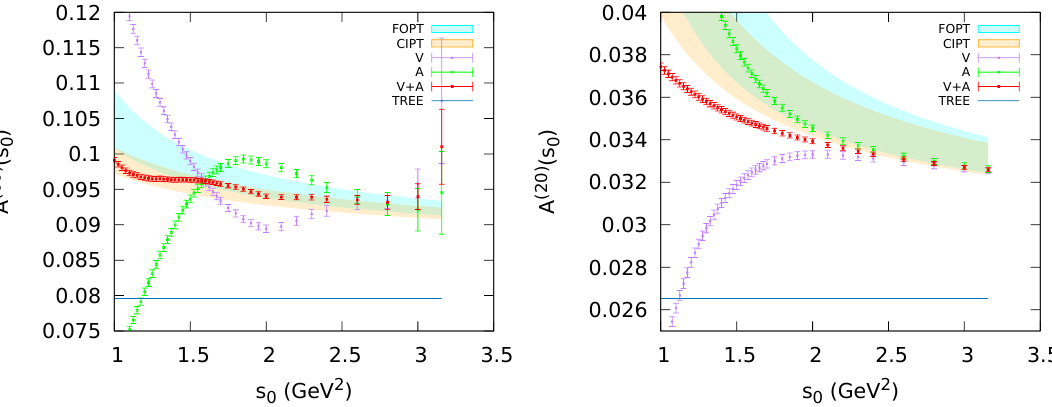
( s ) for the V (purple), A (green) Figure 3 . Dependence on s 0 of the experimental moments A ω 0 J and 1 ( V + A ) (red) channels. The left plot corresponds to the weight ω (0 , 0) ( x ) = 1 , and the right 2 one to ω (2 , 0) ( x ) = (1 − x ) 2 . The orange and light-blue regions are the CIPT and FOPT perturbative predictions for α ( m 2 ) = 0 . 329 +0 . 020 [40]. The blue horizontal lines at the bottom indicate the s τ − 0 . 018 parton-model